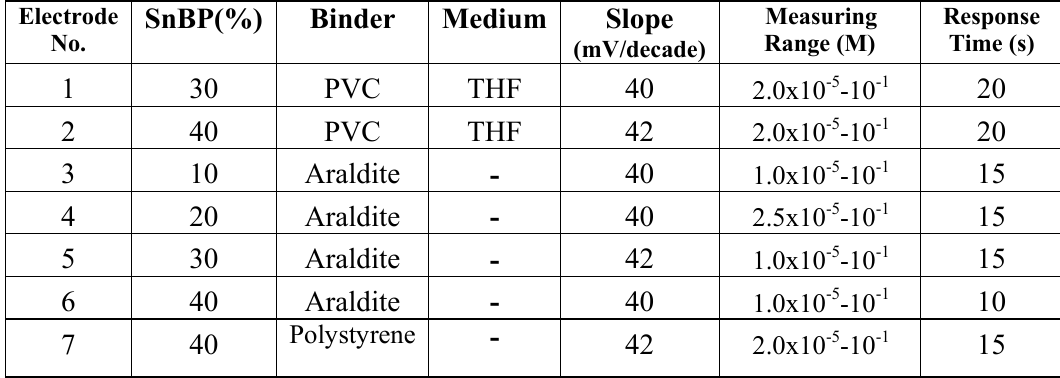
Table 1. Optimization of membrane